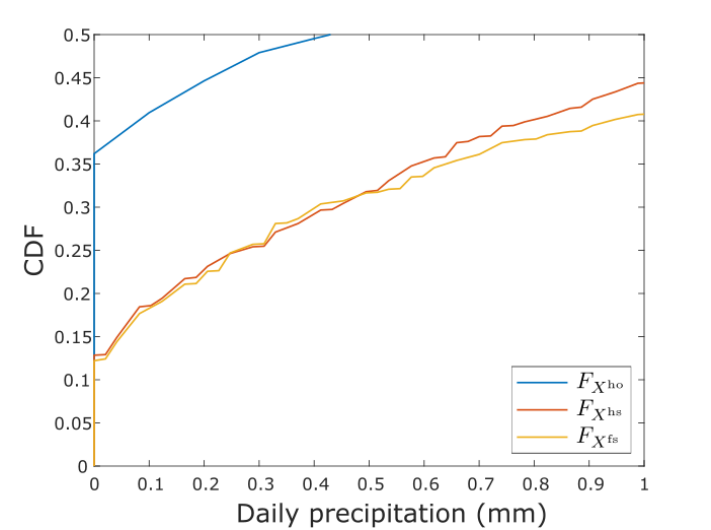
Figure 1. CDFs of the historical observations, historical simulations and future simulations used in this study for daily precipitation depths ranging between 0 and 1